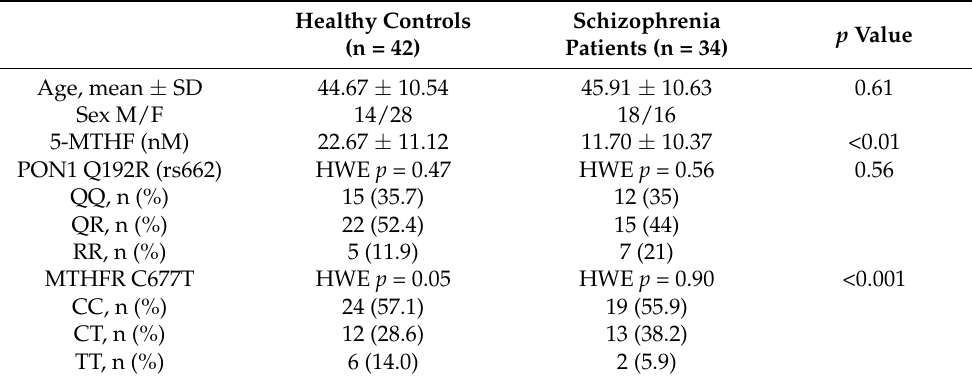
Table 3. Demographics of schizophrenia patients vs. healthy